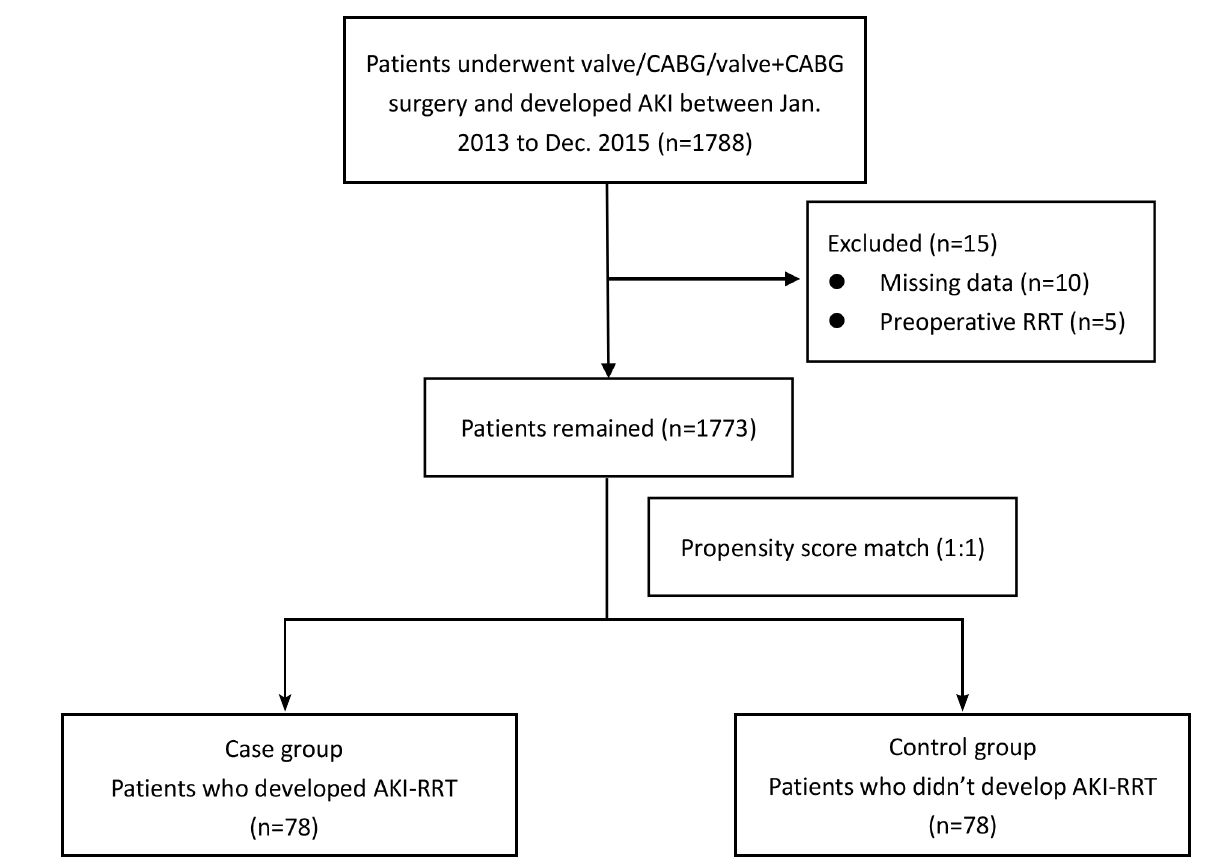
Fig. 1 – Flow diagram outlining the inclusion and exclusion criteria and study design. AKI=acute kidney injury; CABG=coronary artery bypass grafting; RRT=renal replacement